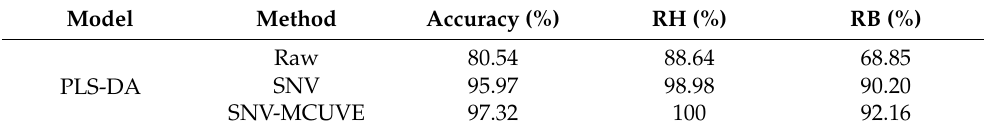
Table 2. The results of PLS-DA discriminative models for pear quality based on different modeling variables.